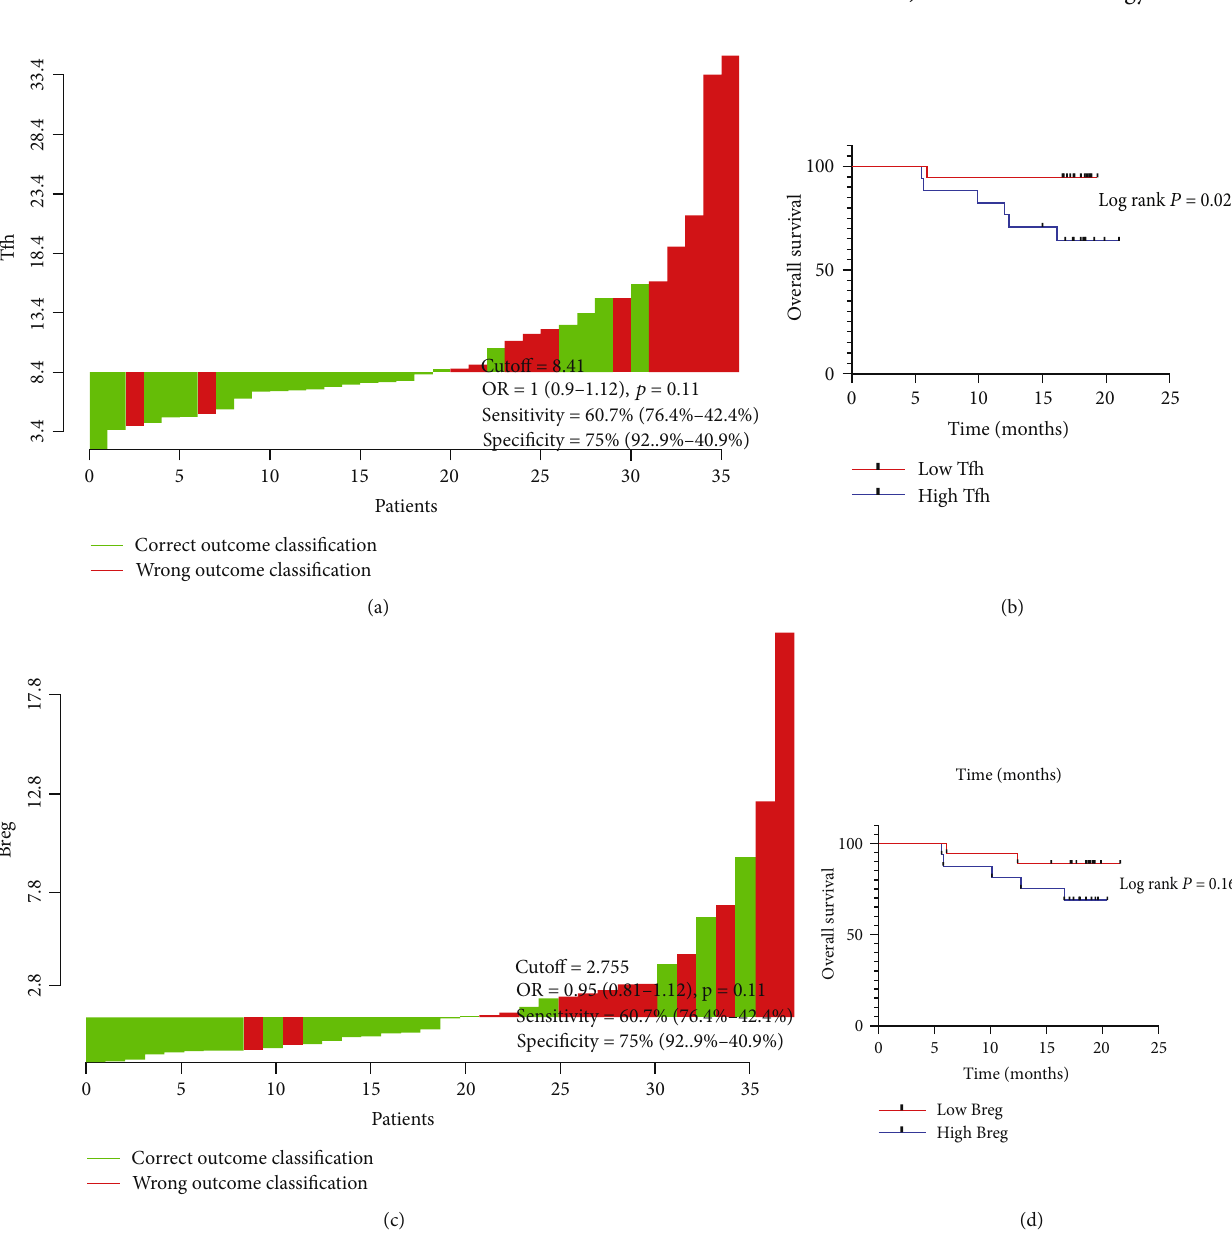
Figure 3: The overall survival (OS) curve for gastric cancer patients according to Tfh and Breg expressions. Cuto ff Finder for the optimal cuto ff values of Tfh% and Breg%. The cuto ff value of Tfh was 8.41% with the sensitivity of 60.7% and the speci fi city of 75.0% (a), while Breg was 2.755% with the sensitivity of 60.7% and the speci fi city of 75.0% (c). The patients were strati fi ed into two groups with cuto ff values, respectively. The Kaplan-Meier analyses for Tfh and Breg in gastric cancer showing low Tfh% were associated with better prognosis (b, P < 0 : 05 ), while the percentage of Breg had no signi fi cant prognostic value (d, P > 0 : 05 ). The log-rank test calculated P values. Tfh: follicular help T cells; Breg: regulatory B